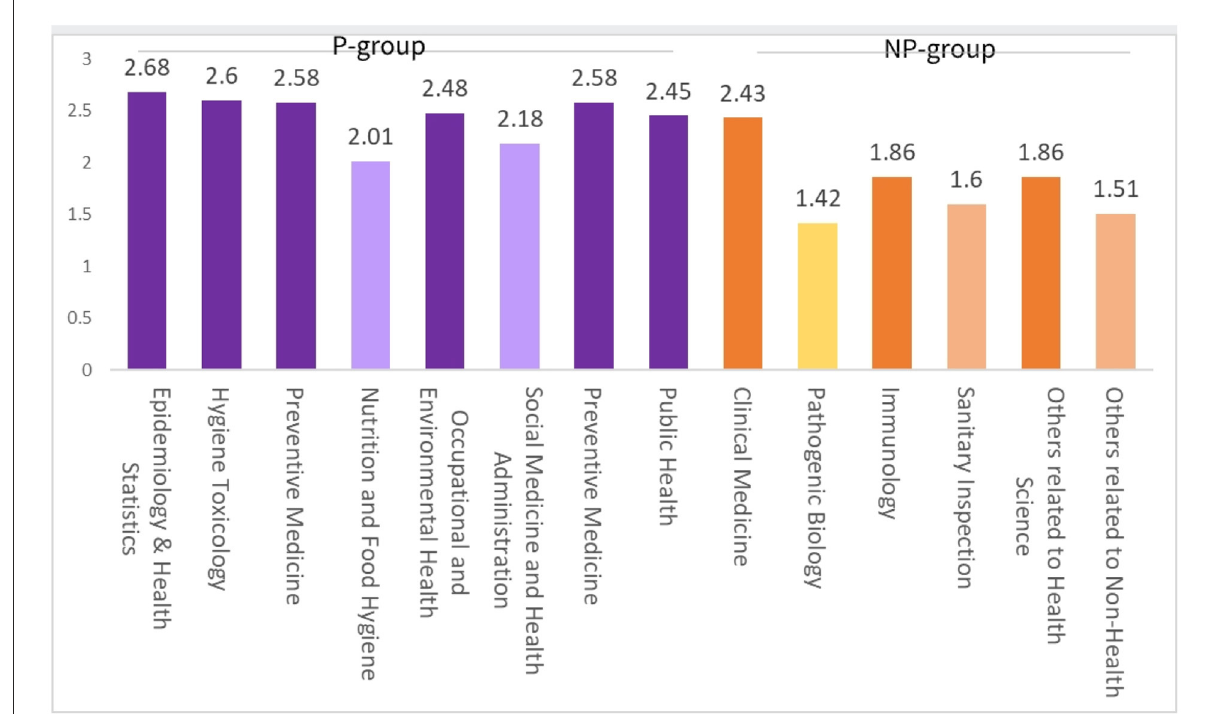
FIGURE2 Distribution of epidemic prevention and control duties per-person in different disciplines during COVID-19 pandemic within Beijing Disease Prevention and Control System.